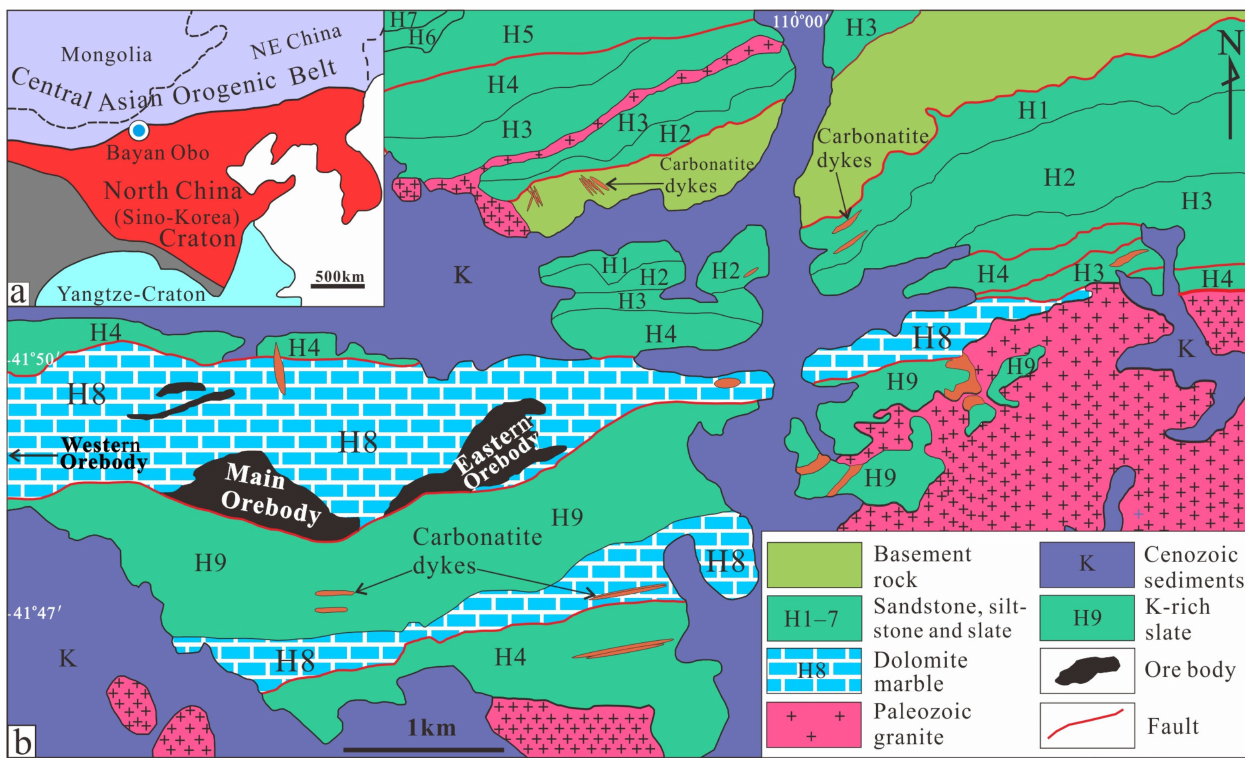
Figure 1. ( a ) Geotectonic sketch and ( b ) geological map of the Bayan Obo REE-Nb-Fe deposit (modified from